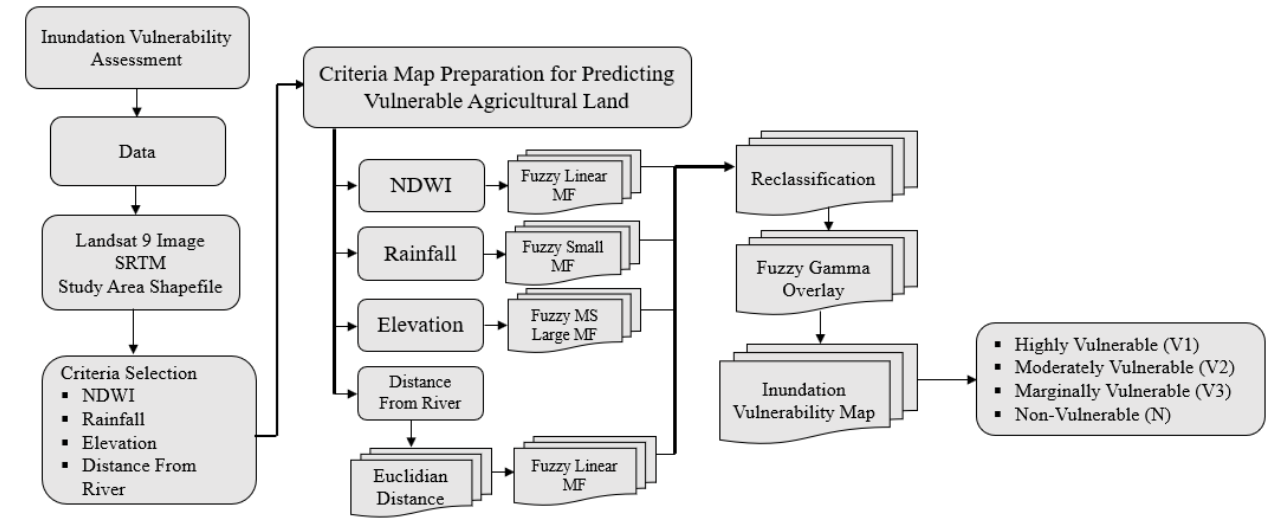
Figure 2. Stepwise workflow for inundation vulnerability assessment in the riverine area.